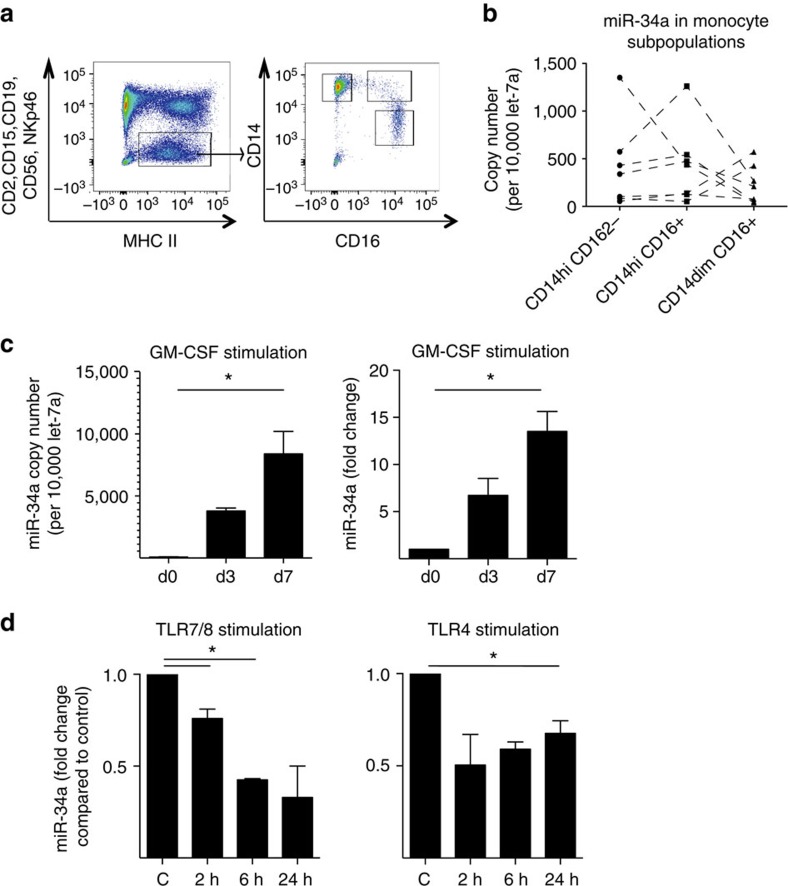
MiR-34a expression is regulated by GM-CSF and TLR ligands.(a) A representative FACS-gating strategy for sorting healthy donor human blood monocyte subsets. (b) Each monocyte subset expressed low copy numbers of miR-34a relative to let-7a housekeeping control (c), which increased following differentiation with GM-CSF (50 ng ml−1) for 3 and 7 days. Data in b are presented as a dot plot with dotted lines joining the cells from the same donor for clarity. (d) Monocyte-derived DCs (n=3) were stimulated with TLR agonists CL097 (TLR7/8; 1 μg ml−1) or LPS (TLR4; 1 ng ml−1) or left un-stimulated (control, C), which decreased miR-34a expression between 2 and 24 h. *P<0.05; one-way ANOVA with Tukey’s multiple comparison test. Data are presented as mean±s.e.m. copy number normalized to let7a or fold-change compared to the respective time point control (n=3-4 biological replicates from three independent experiments).